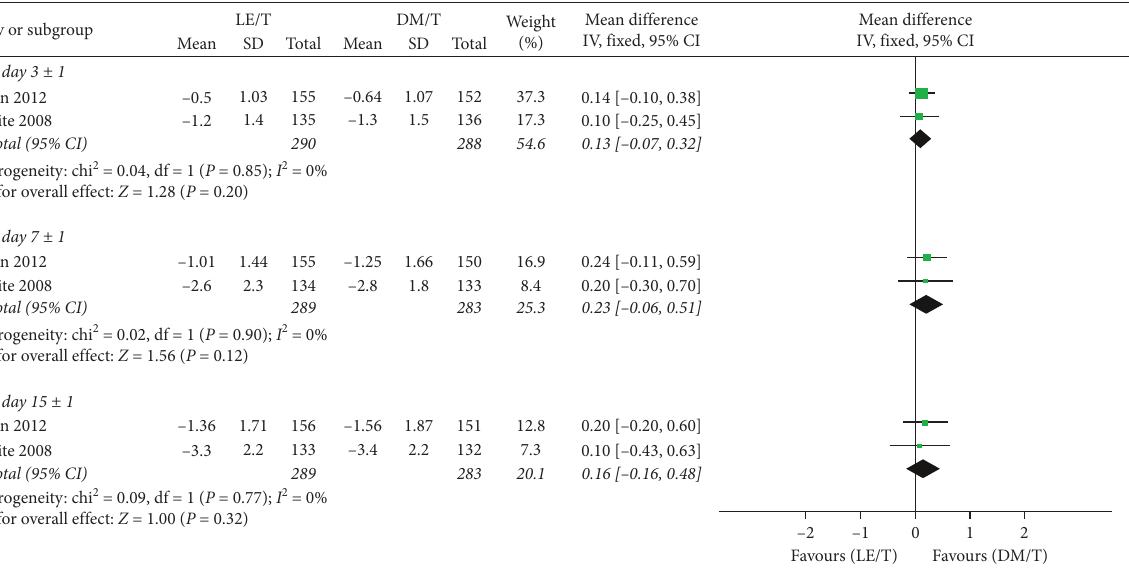
Figure 5: Forest plot of CFB in the blepharitis signs composite